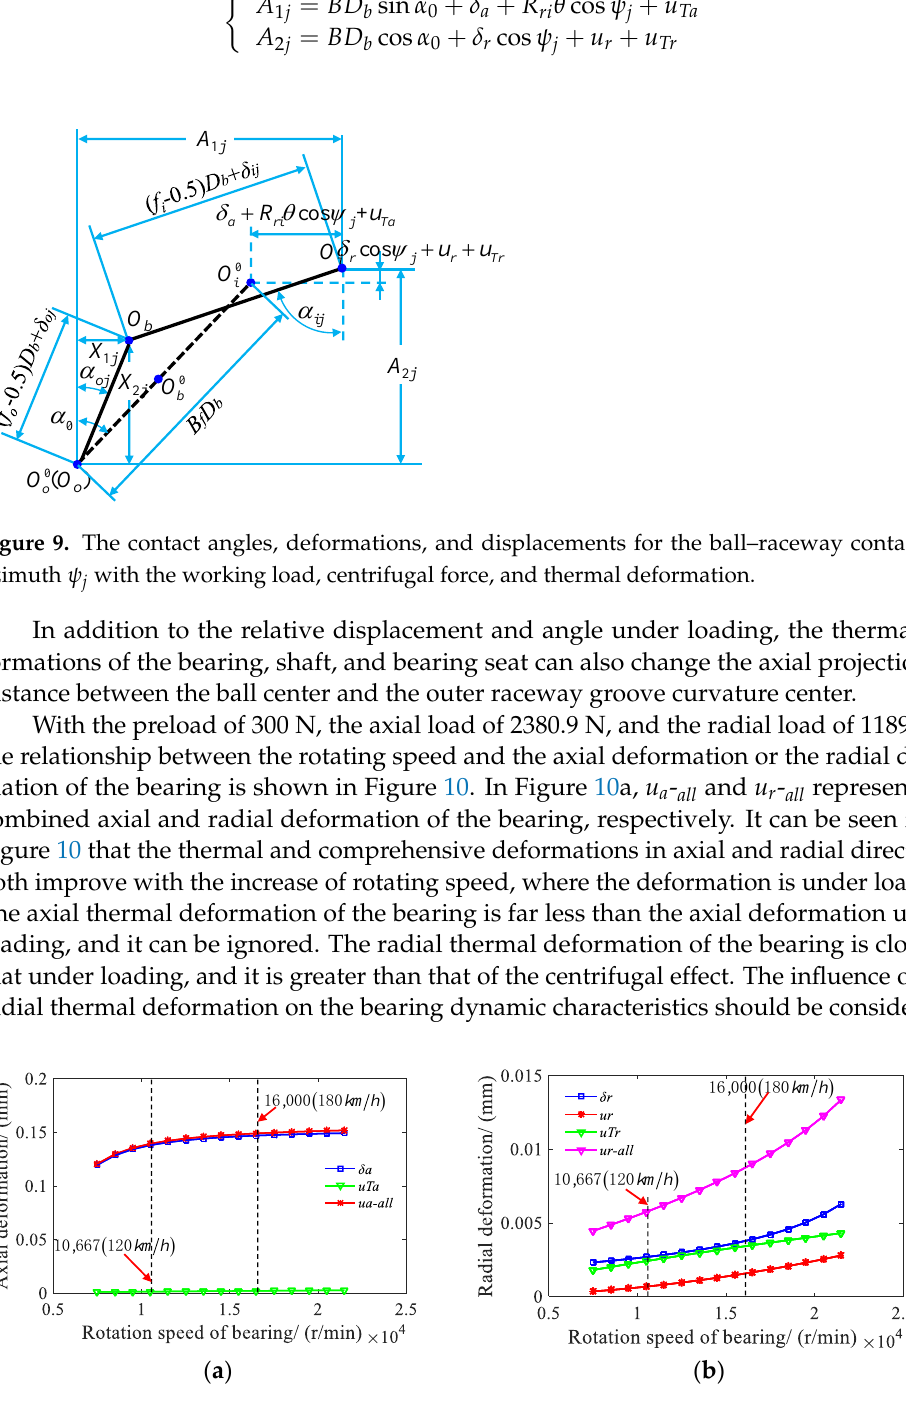
Figure 10. ( a ) Axial deformation displacement graph and ( b ) radial deformation displacement graph of the deep groove ball bearing under the centrifugal effect and thermal deformation.